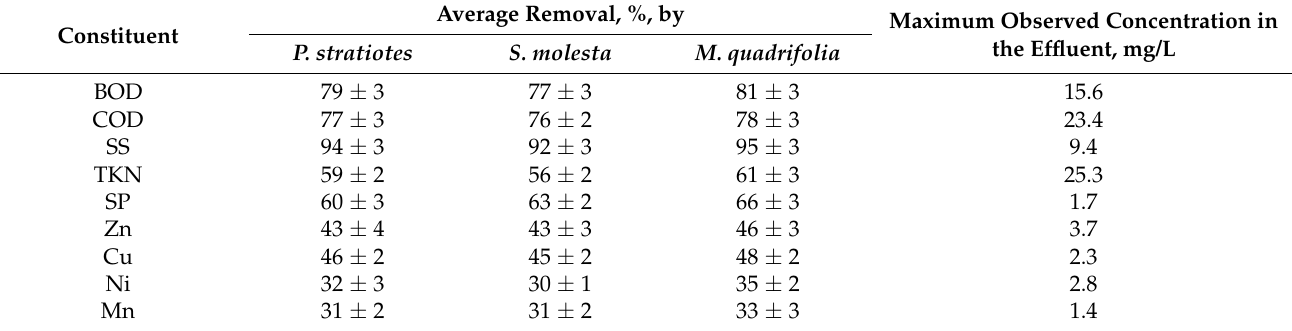
Table 4. Average removal of different constituents at of each constituent steady state by the three macrophytes at the HRT of 2 h, and the maximum concentration recorded in the effluent. Average Removal, %, by Maximum Observed Concentration in Constituent the Effluent, mg/L P. stratiotes S. molesta M. quadrifolia